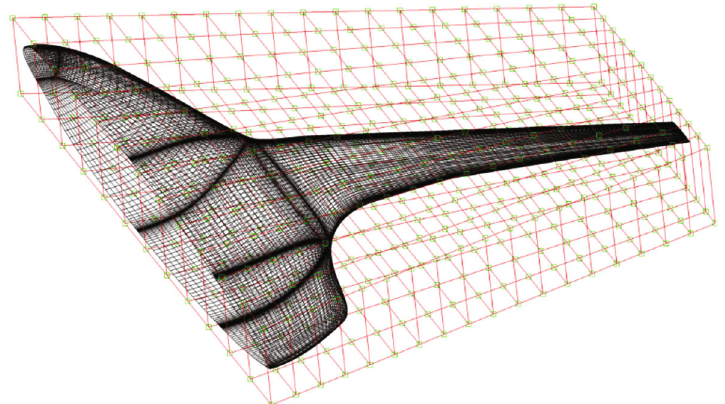
Figure 13: FFD box of SWB N.